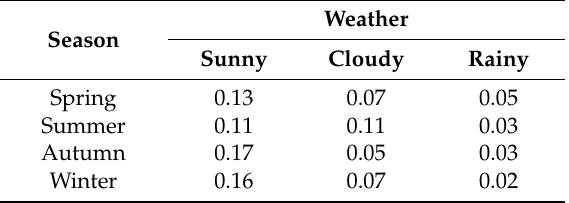
Table 1. The probability of typical temperatures throughout one year.